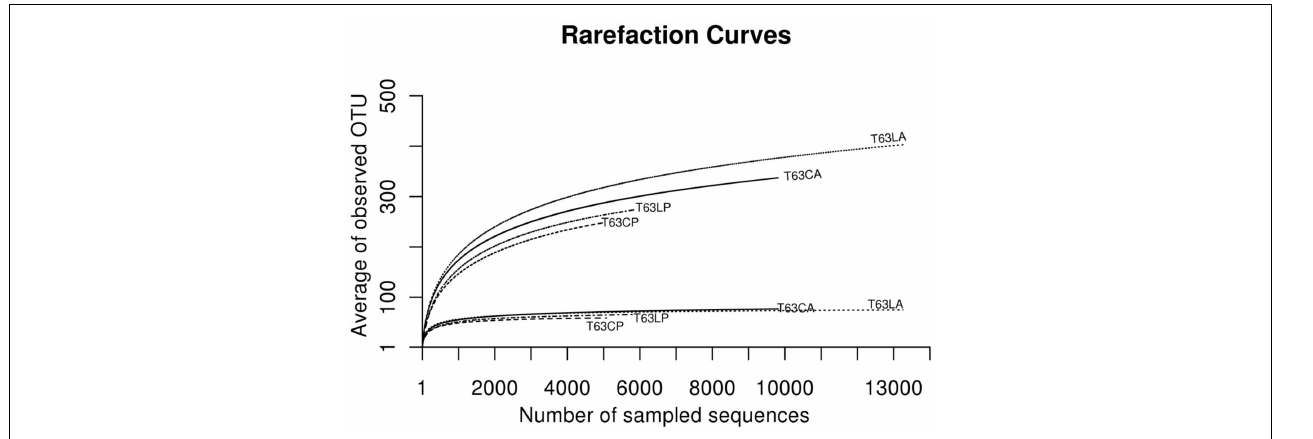
FIGUREA6 | Plot of rarefaction curves at 80 and 70% similarities for soils spiked with phenanthrene (LP: phenanthrene-spiked Luvisol, CP: phenanthrene-spiked Cambisol) or not (LA: Luvisol control, CA: Cambisol control) on day 63 (T63).